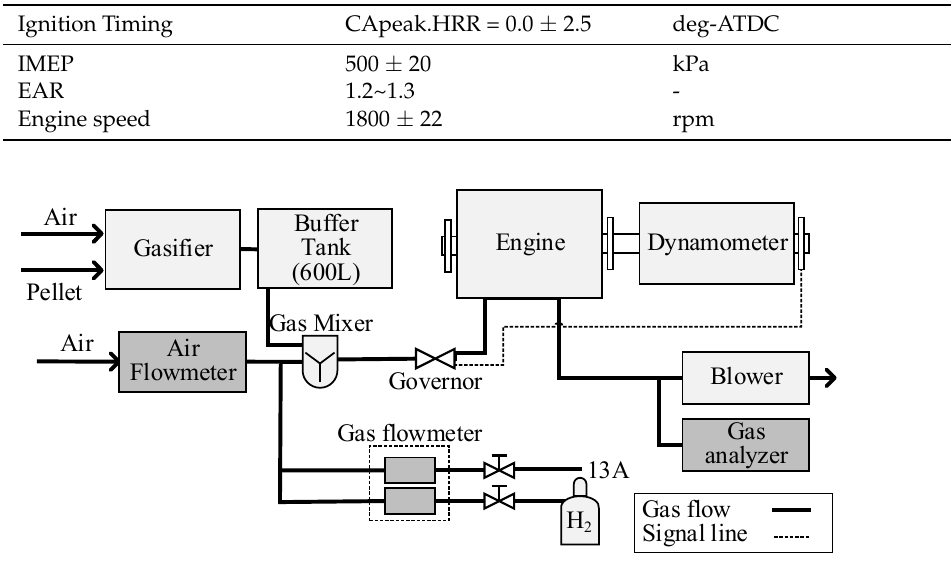
Table 2. Operating conditions of spark ignition reciprocating engine.